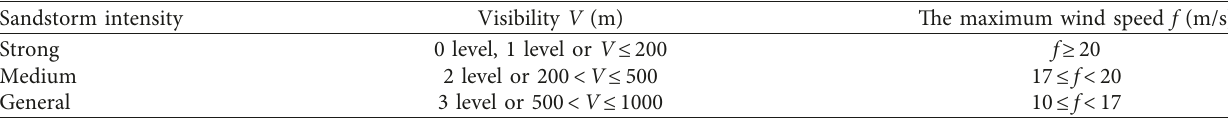
Figure 2: Establishment process of sandstorm prediction model based on naive Bayesian Table 2: Single-station strong sandstorm standard.